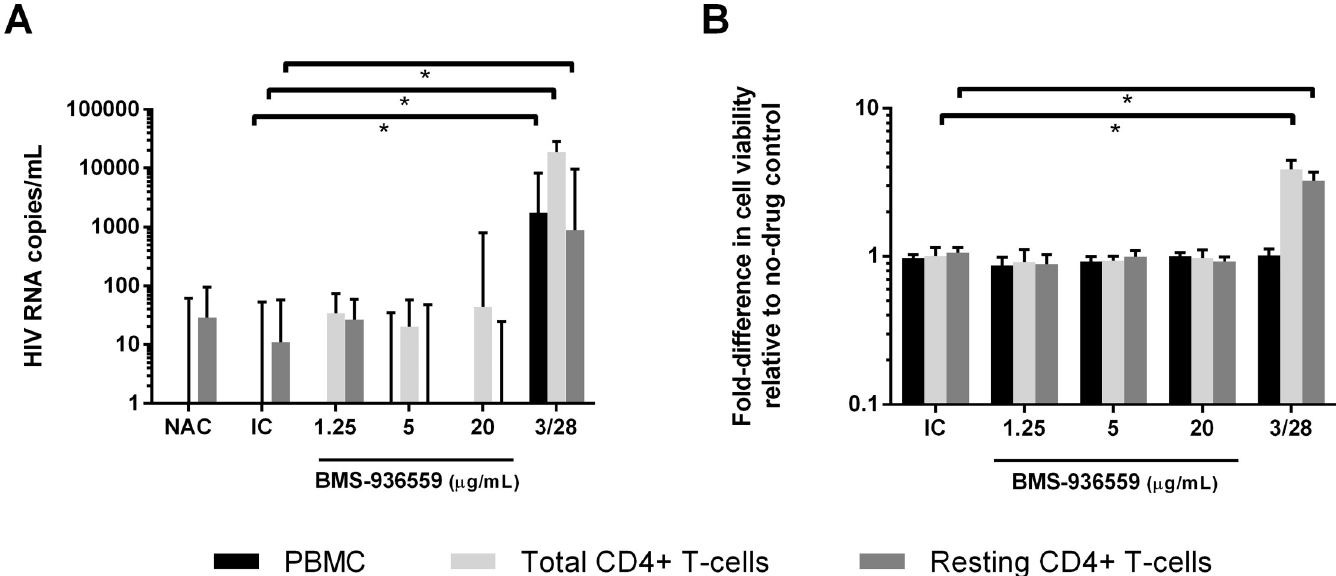
Fig 1. Virion production and cell viability in response to BMS-936559. Median HIV-1 virion production across all donors after 7 days of stimulation with BMS- 936559 (Fig 1A). Median fold-change in cell viability across all donors from no-Ab control after 7 day treatment with BMS-936559 (Fig 1B). � = multiplicity adjusted, p < 0.05 by Wilcoxon matched-pairs signed rank test with Bonferroni correction. NAC = no-Ab control; IC = isotype control; 3/28 = anti-CD3/CD28. Error bars = Interquartlie range (IQR).